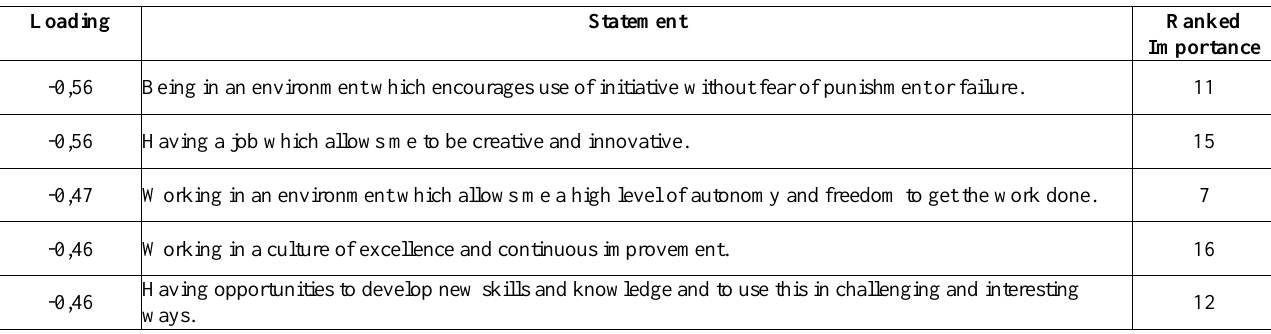
Table 4: Variables associated with factor two